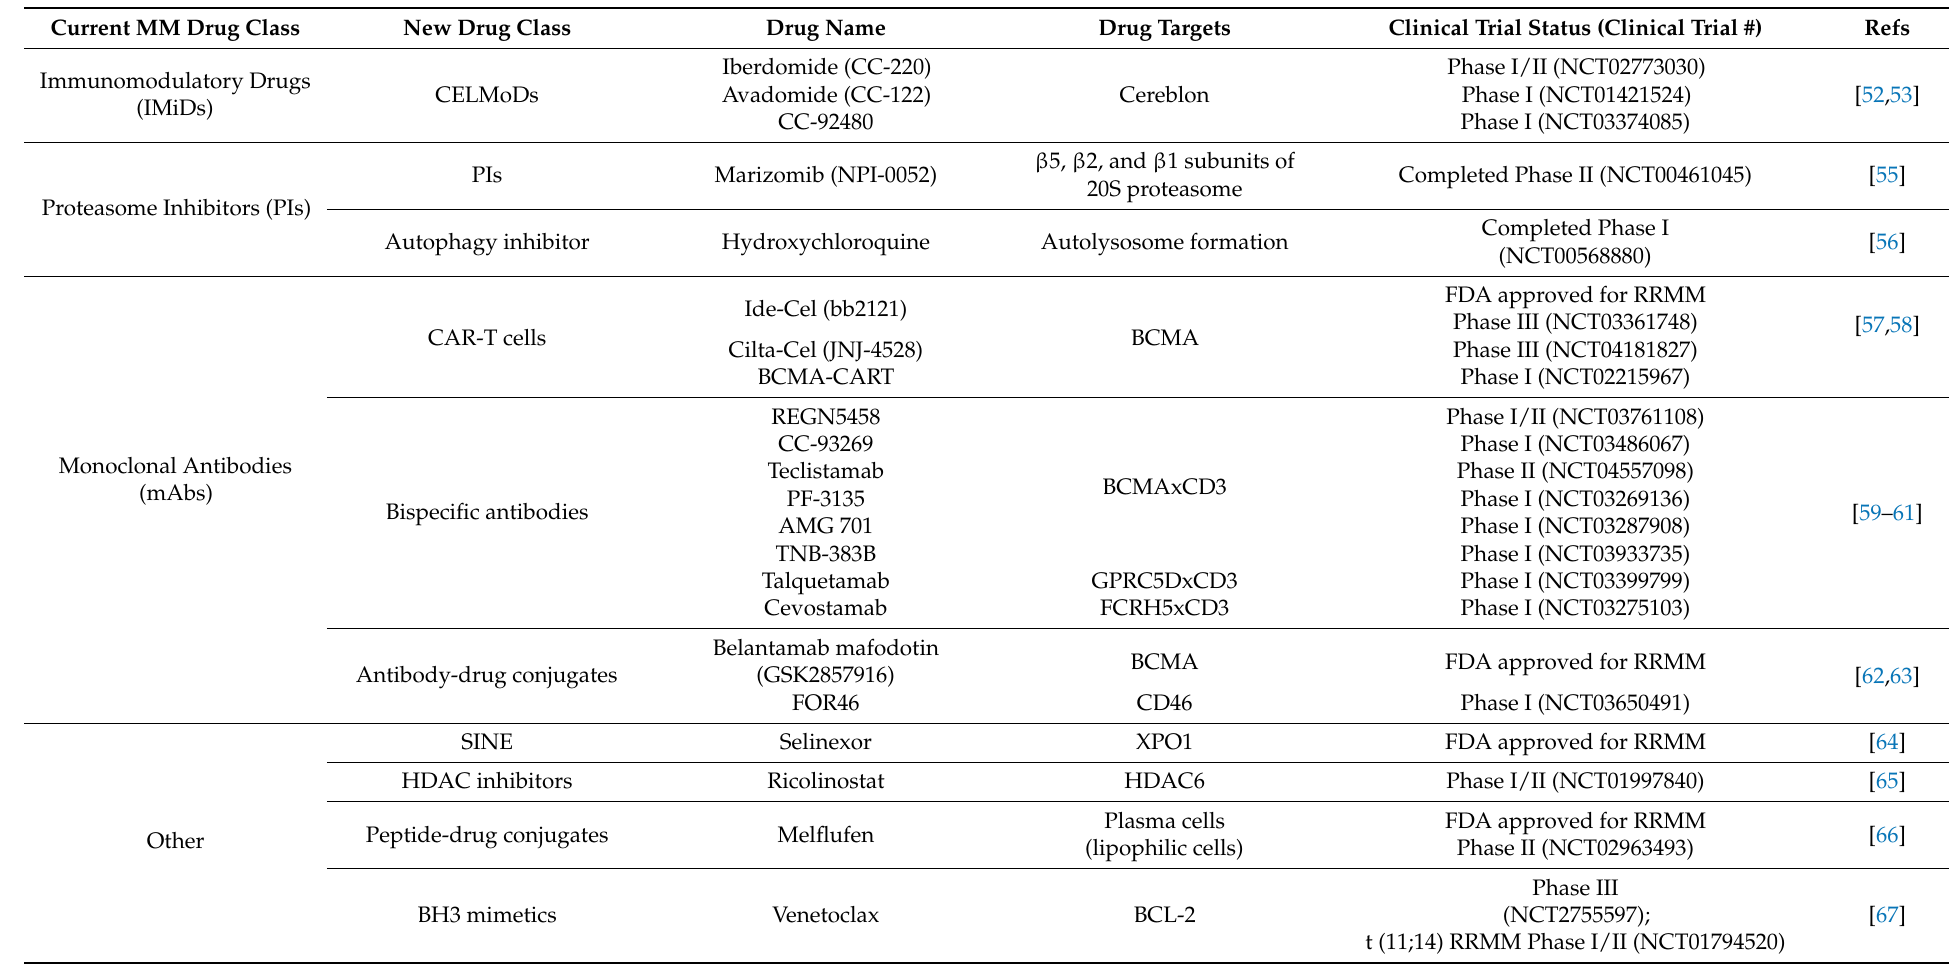
Table 2. Key therapies currently in clinical trials for overcoming drug resistance in multiple